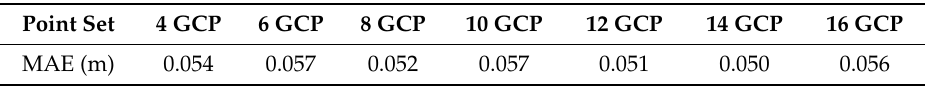
Table 1. Mean absolute errors between RTK-GPS measured and drone derived elevations for a flight conducted with 80% overlap and varying numbers of GCPs